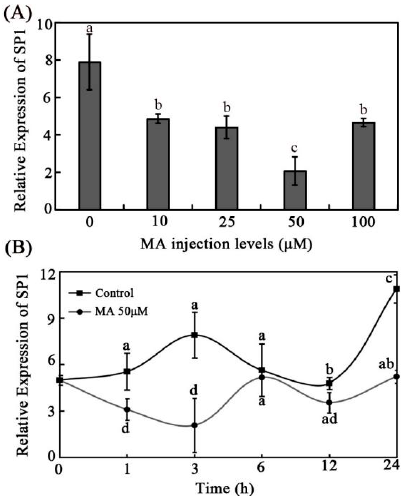
Figure 4. The effect of MA (SP1 inhibitor) on the expression of SP1 in intestines of grass carp. ( A ) The relative mRNA expression of SP1 with different levels of MA injection. ( B ) The relative mRNA expression of SP1 with 50 μ M MA injection for different time. The data represent the mean ± SD. Tukey’s multiple range test was performed, and different letters represent significant differences ( p < 0.05, n = 3 for each treatment with three replicates).